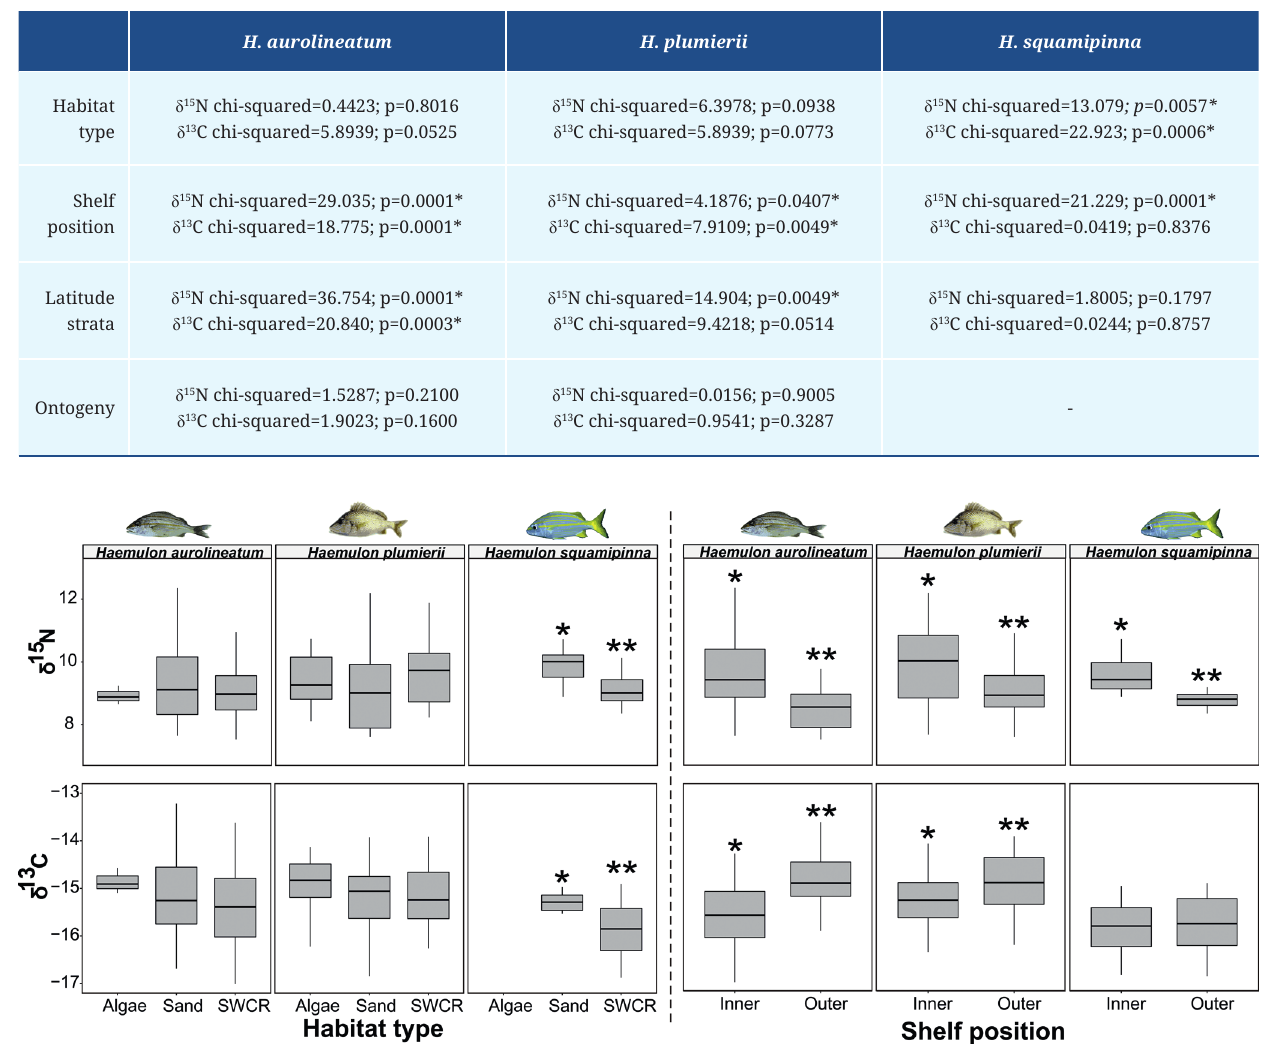
FIGURE 4 | Isotopic ratios of carbon ( δ¹³ C) and nitrogen ( δ 15 N) of Haemulon plumierii , H. aurolineatum , and H. squamipinna in different habitats and shelf position captured along the northeast coast of Brazil. The black horizontal line and box represent the median value and the interquartile range, while the vertical lines represent the upper and lower limits. Outliers were not included in the plot. Different symbols (* and **) represent significant